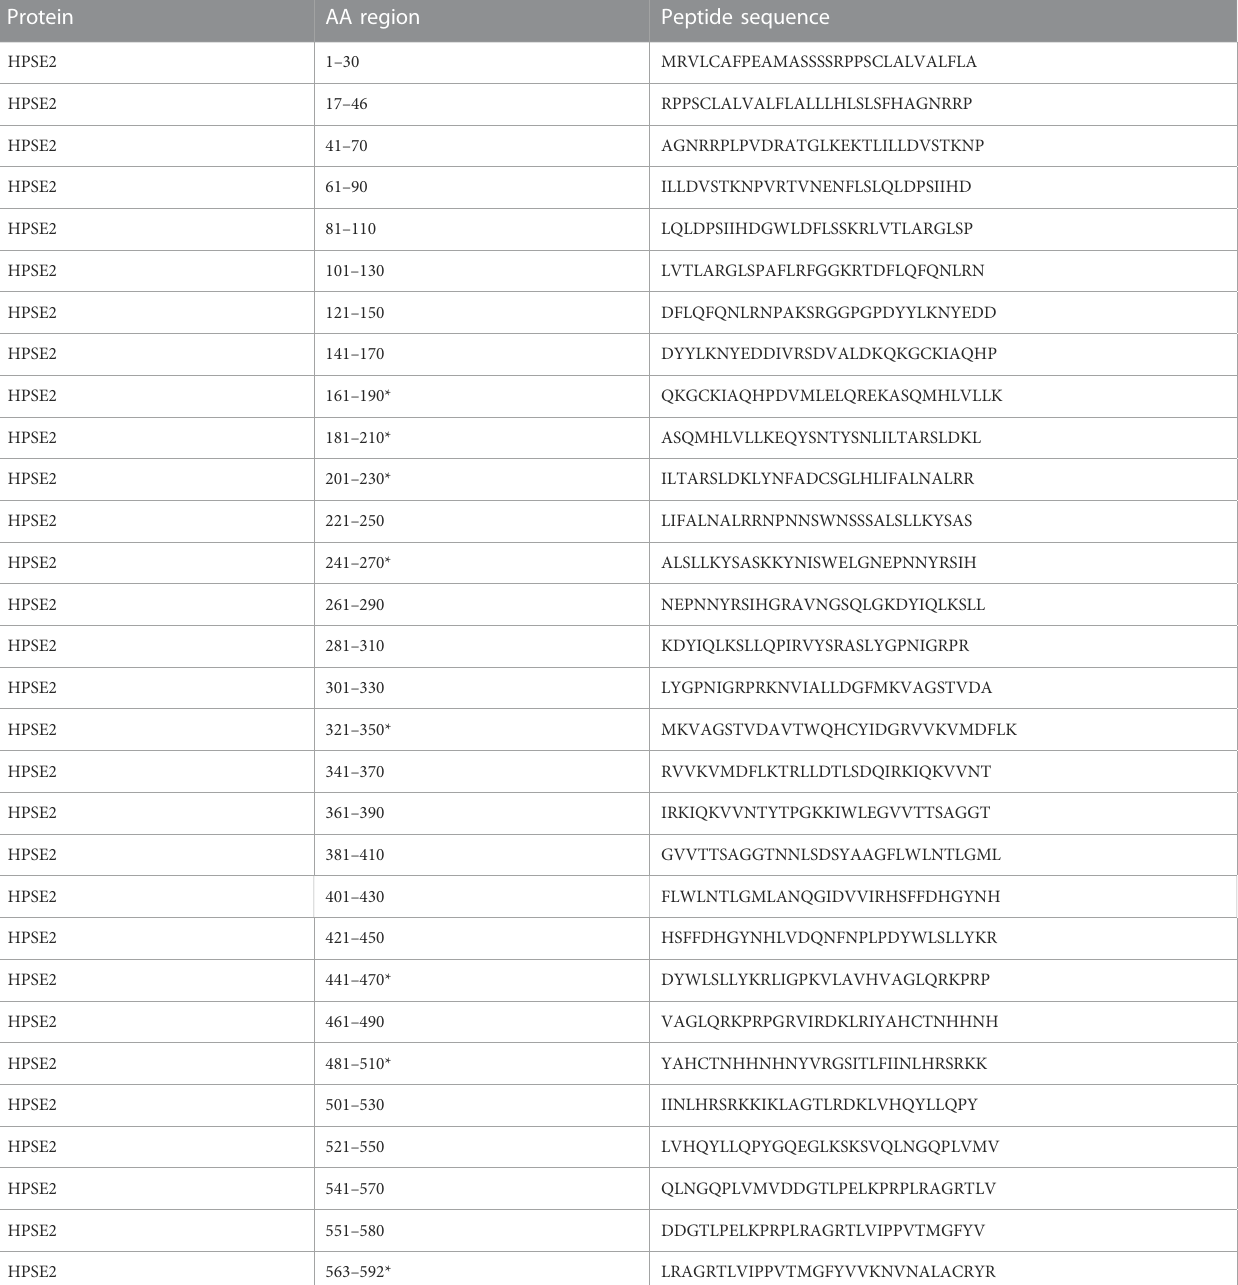
TABLE 3 Sequences of the designed HPSE2